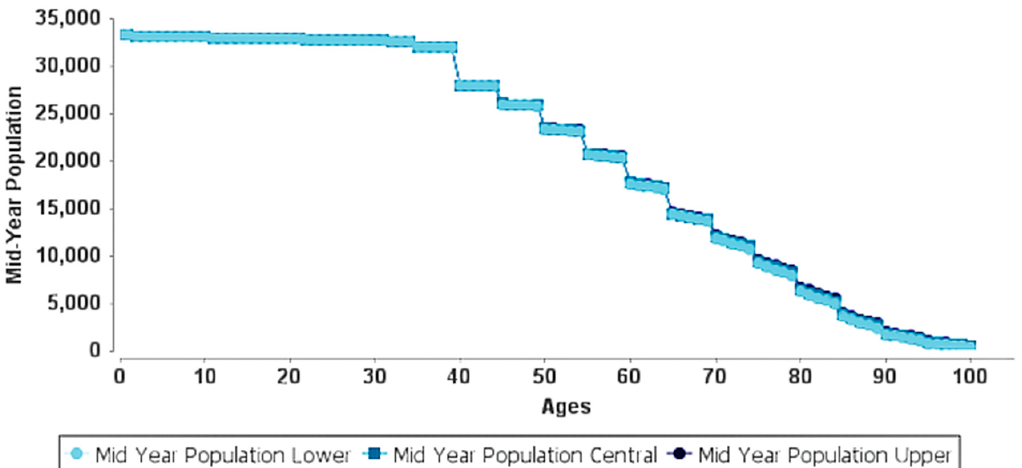
Figure 3. AirQ+ life table evaluation for the year 2045 (30-year forecast) if PM 2.5 is reduced to the cut-off level (35 μ g/m 3 ).